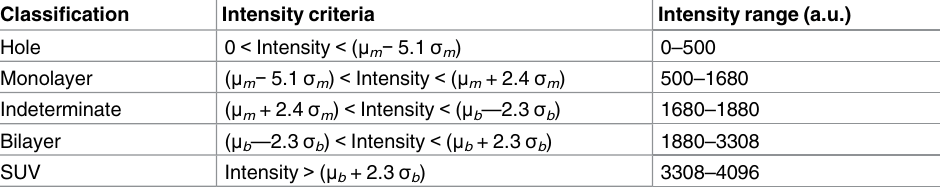
Table 1. Table of intensity values employed to classify pixels in lipid layers.